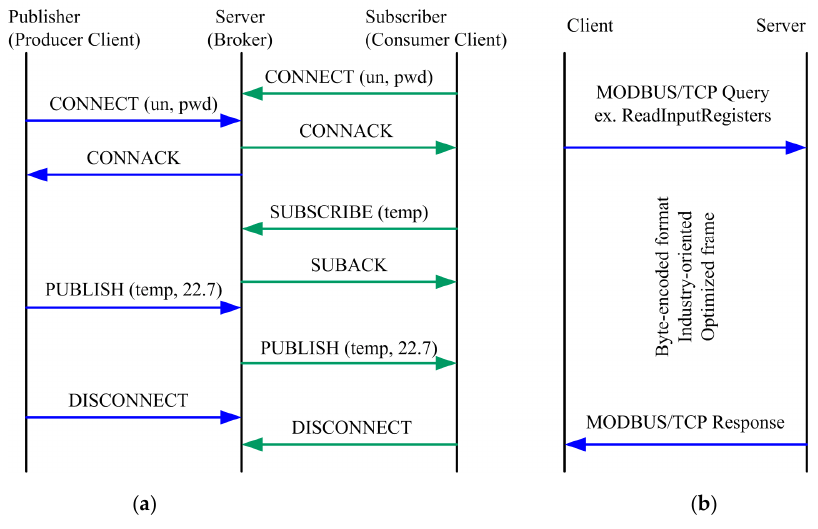
Figure 6. Comparison of protocols for the exchange of messages: ( a ) MQTT; ( b ) MODBUS TCP.